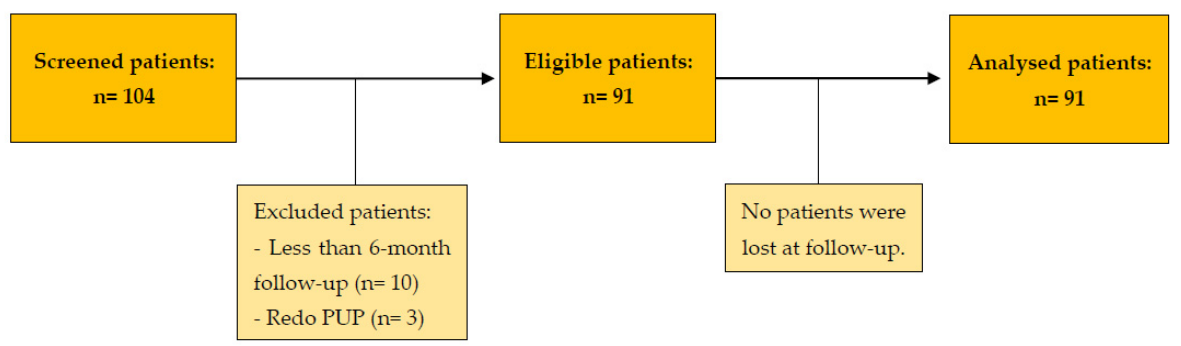
Figure 3. Study fl ow chart. n: number; PUP: pyelureteroplasty. Figure 3. Study flow chart. n: number; PUP: